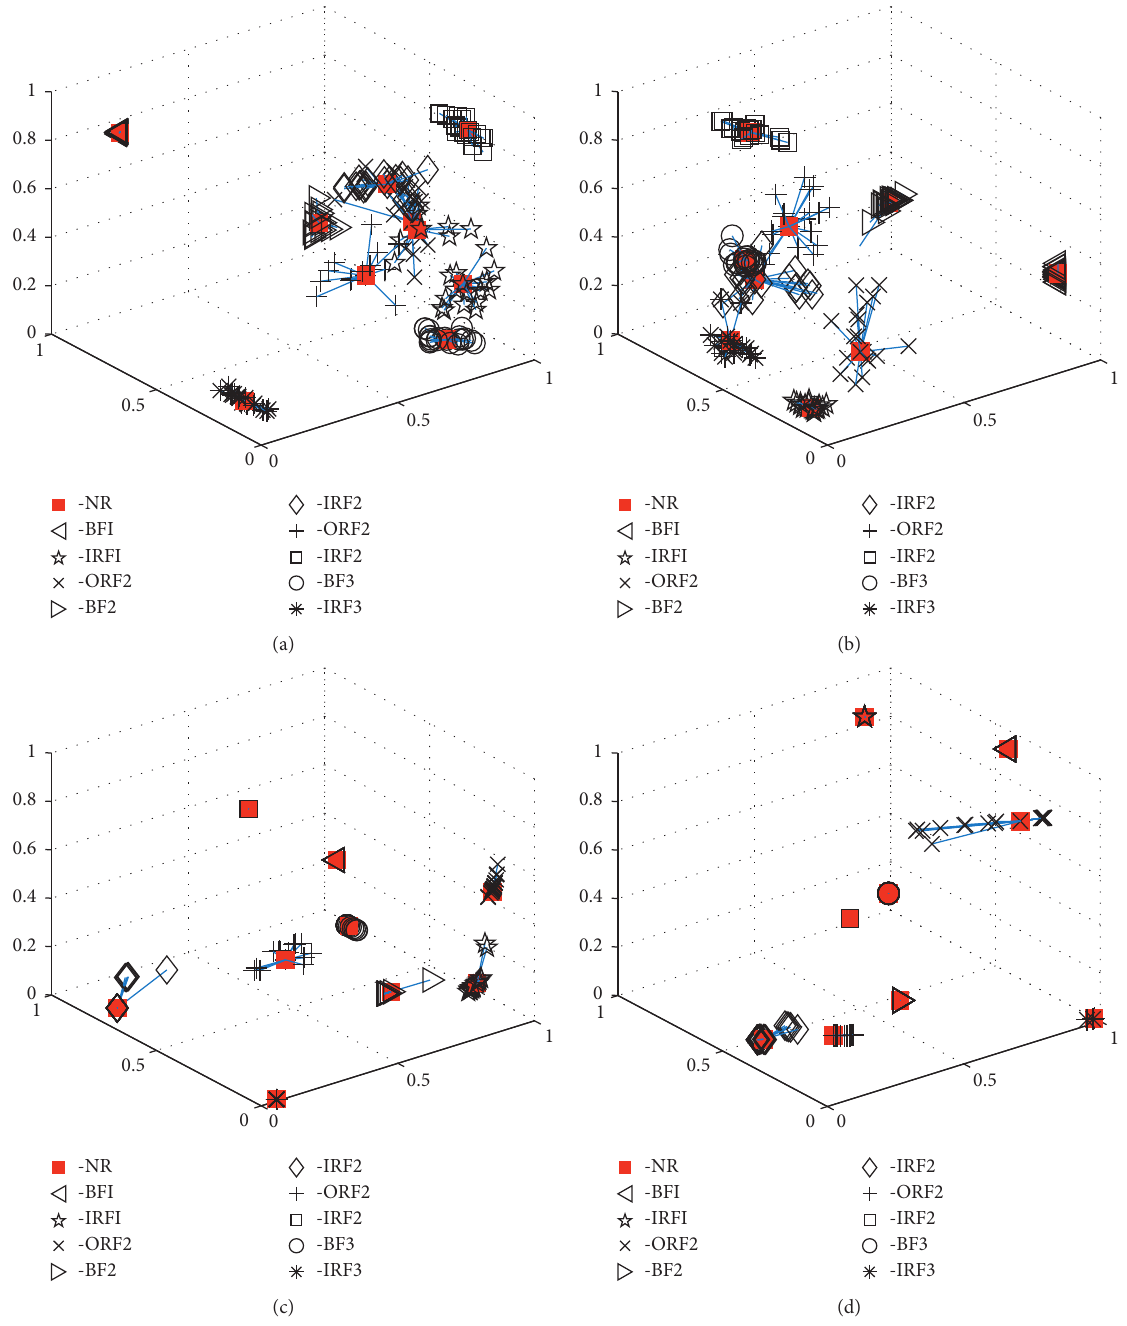
Figure 15: The 3-dimensional clustering results for the testing dataset by using an SAE/SDAE with adAP. (a) SAE-A-testing data-adaptive Table 5: The results of the Silhouette index with different cluster numbers by using an SAE/SDAE with adAP (the testing dataset). Model